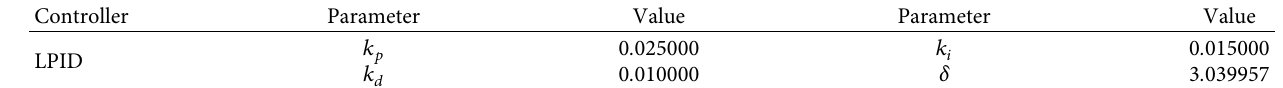
Table 3: LPID parameters.